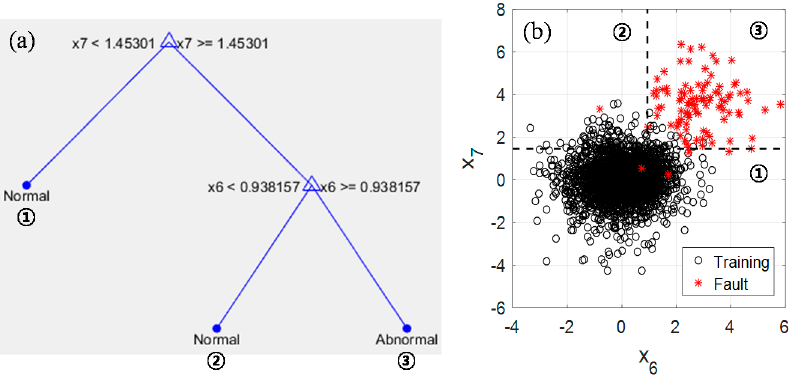
Figure 11. Constructed tree for variable ranking in Figure 10b and relevant scatter plot for normal and faulty samples: ( a ) final tree; ( b ) scatter plot for normal and faulty samples.